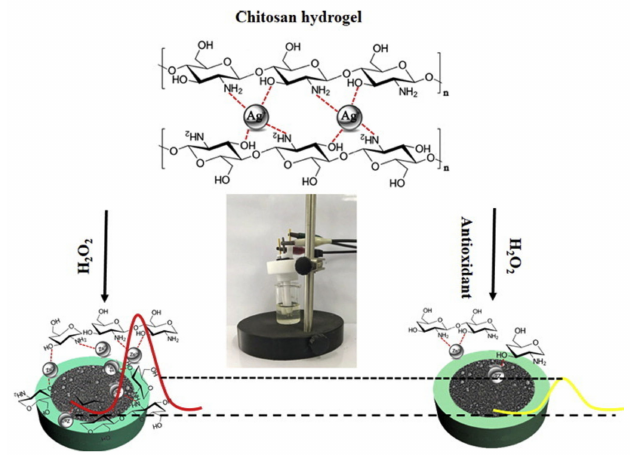
Figure 8. ( a ) Scheme of chitosan chelating silver ions and its redox property during the hydrogel depolymerization in the absence and presence of antioxidants. ( b ) DPV curves of the oxidation response in presence of hydrogen peroxide at various concentrations of ascorbic acid. Reprinted with permission from reference [82]. Copyrights 2017 Published by Elsevier